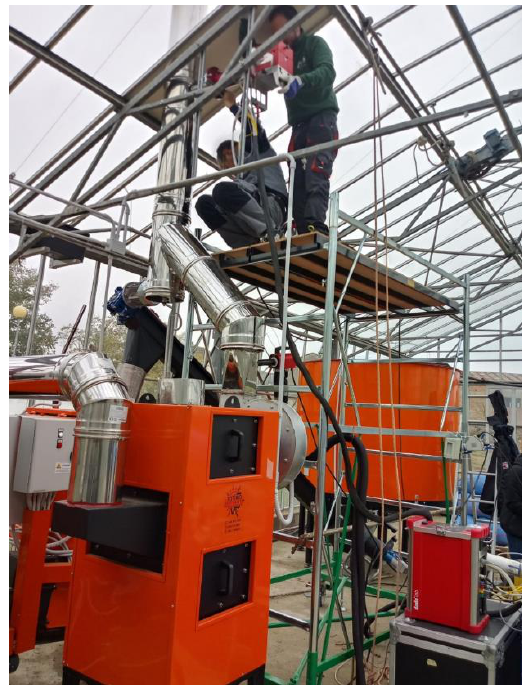
Figure 1. Isokinetic sampling of organic pollutants at the